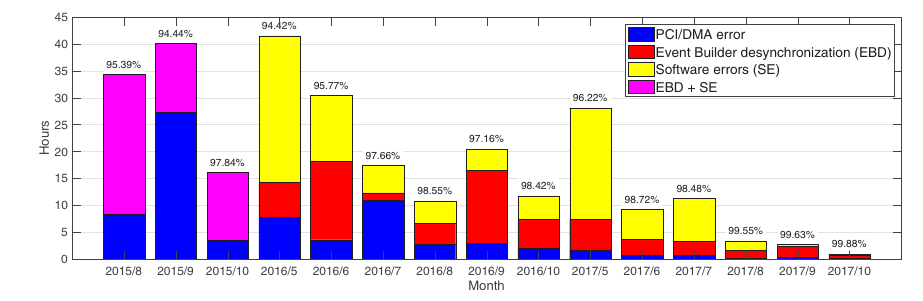
Figure 2. Absolute downtime of the iFDAQ per month and corresponding relative